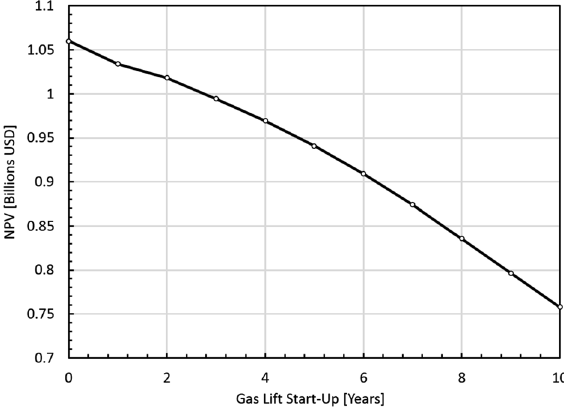
Fig. 20 NPV as a function of gas lift start-up